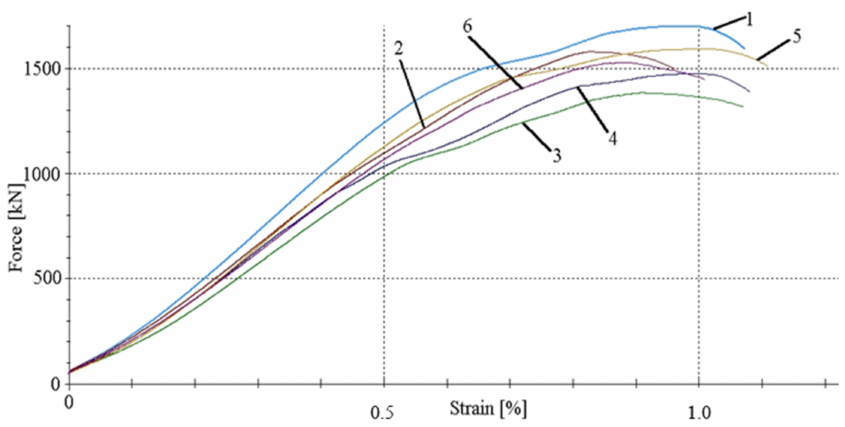
Figure 9. Force–strain relationships for concrete in beams A2M and